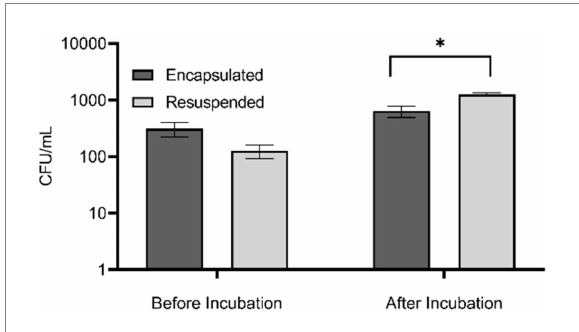
FIGURE 1 Abundance of bacteria in encapsulated and resuspended marine sediment bacteria samples before and after in situ incubation based upon colony counts performed in triplicate. Error bars indicate standard error, * denotes significance of p < 0.01. Is this correct?